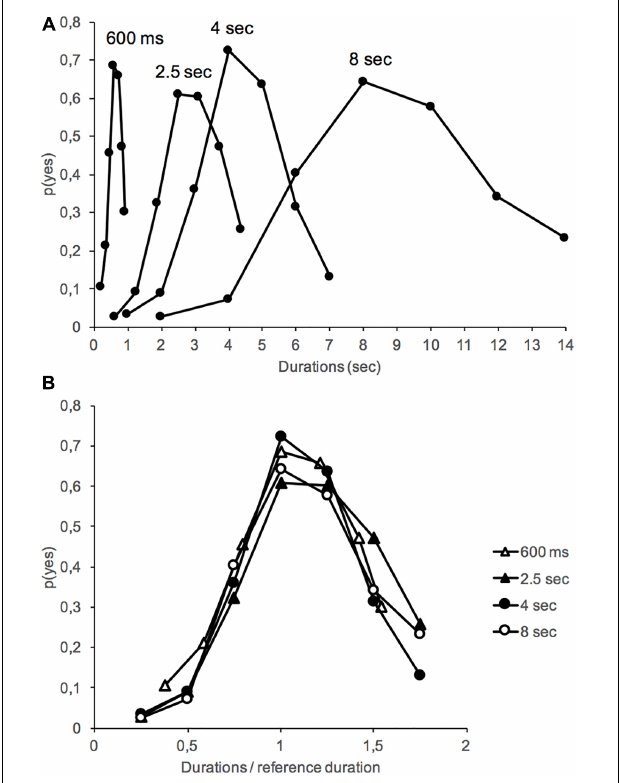
FIGURE 2 | Mean proportion of “yes” responses obtained in the long-term memory test (24 h after acquisition) plotted against absolute ( A top) or relative ( B bottom) stimulus durations for the 600-ms, 2.5-s, 4-s, and 8-s duration groups.